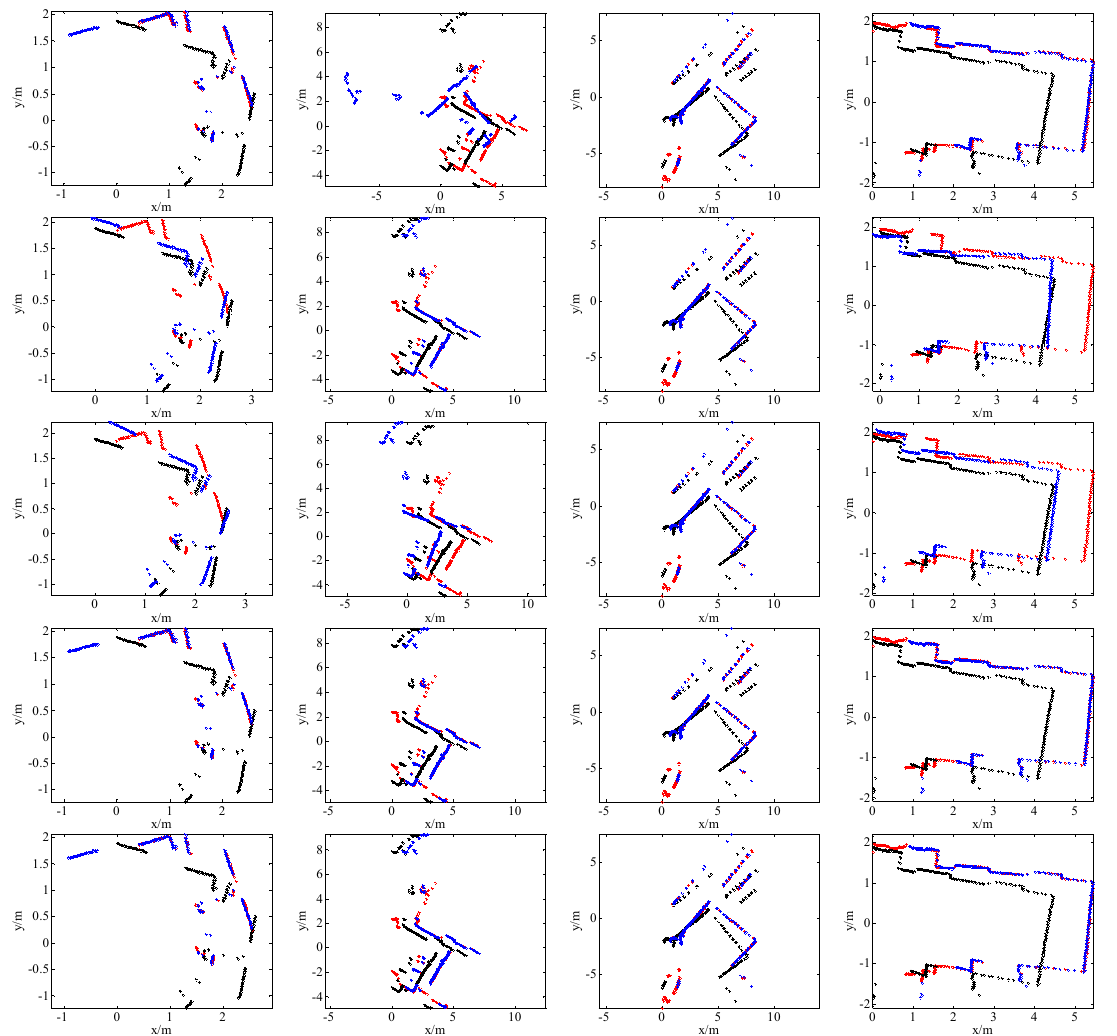
Figure 9. Some scan matching results of the Intel dataset. The first row is the results of PSM; the second row is the results of PLICP; the third row is the results of ICP without an initial guess (ICP 1 ); the fourth row is our scan matching results; the last row is the ground truth. In all these plots, the points denoted by red +, black +, and blue + represent the first laser scan S k -1 , the second laser scan S k , and the transformed laser scan of S k by using the estimated transformation matrix, respectively.